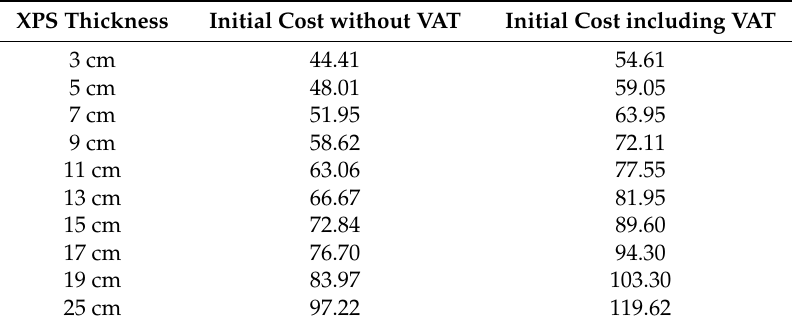
Table 7. Initial investment cost in € /m 2 for each insulation scenario 1 .